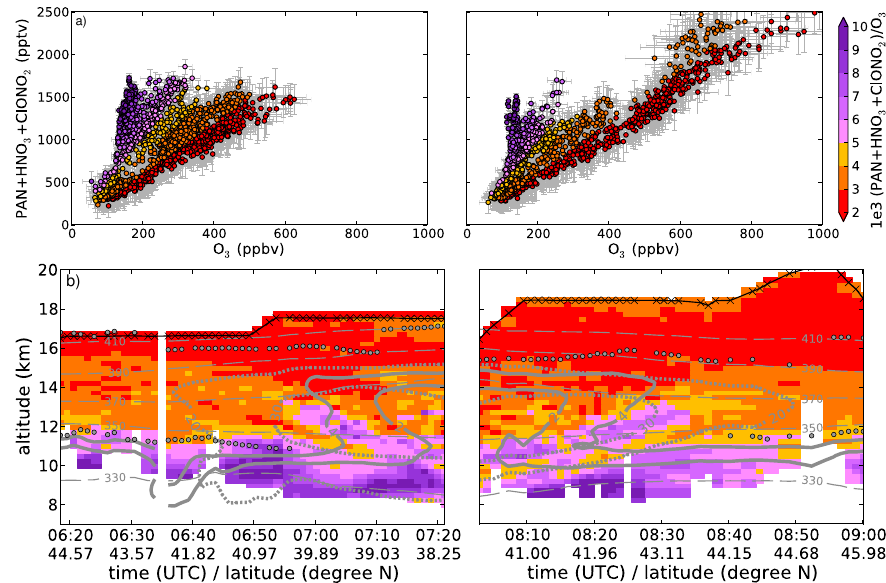
Fig. 11. Relationship of PAN + HNO 3 + ClONO 2 and O 3 . All panels show the western (left) and eastern (right) cross sections separately. (a) shows the location of air parcels in tracer-tracer space. The precision of measurements is indicated by error bars in light grey. Colours are assigned according to the ratio of volume mixing ratios. (b) shows the location of the same air parcels in geophysical space coloured with the same colours used in (a)